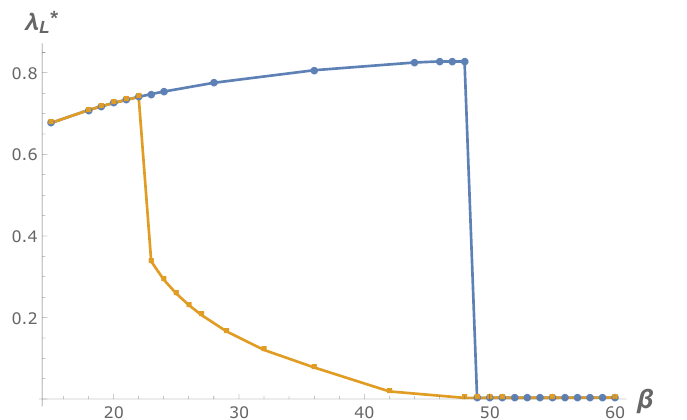
Figure 1. Normalized Lyapunov exponent with varying inverse temperature in the two different phases for η = 0 . 27 (reprinted from [8]). The sharp changes in the blue (orange) curve represents the transition from the highly chaotic liquid (dilute gas) state to the dilute gas (liquid) state. So, the blue (orange) curve mostly constitutes the liquid (dilute gas)